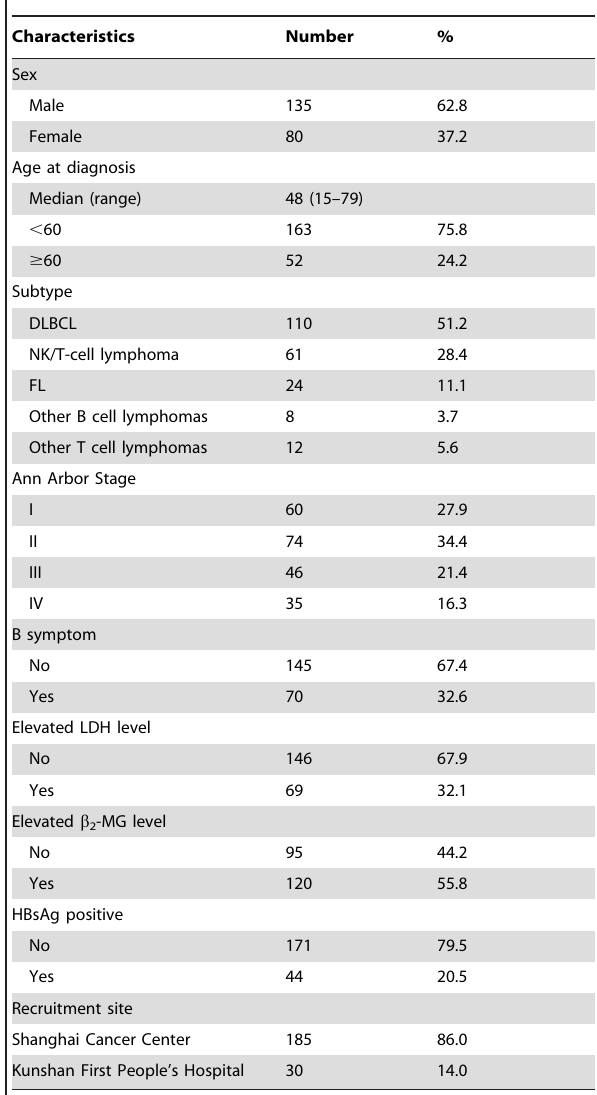
Table 1. Clinical characteristics of 215 NHL